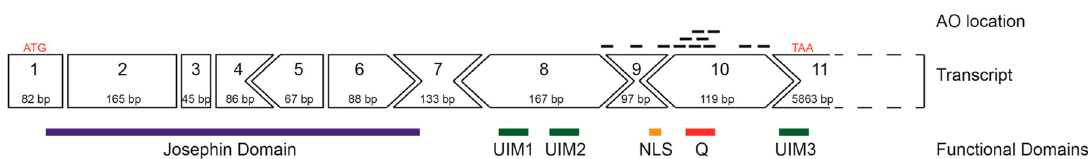
Figure 1. Schematic representation of the ATXN3 gene transcript (ENST00000558190.6) and reading frame, showing location of encoded protein (361 amino acid) domains below the exon map. In-frame exons are represented as rectangles, whereas those bounded by partial codons are represented with chevron sides. Exonic/intronic locations of antisense oligonucleotides designed to redirect ATXN3 pre-mRNA processing are represented as black bars above the transcript.